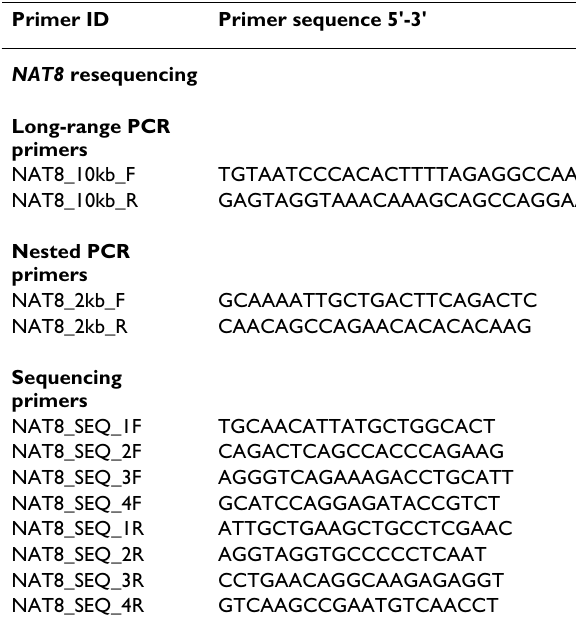
Table 1: PCR and resequencing primers for human NAT8 Primer ID Primer sequence 5'-3' NAT8